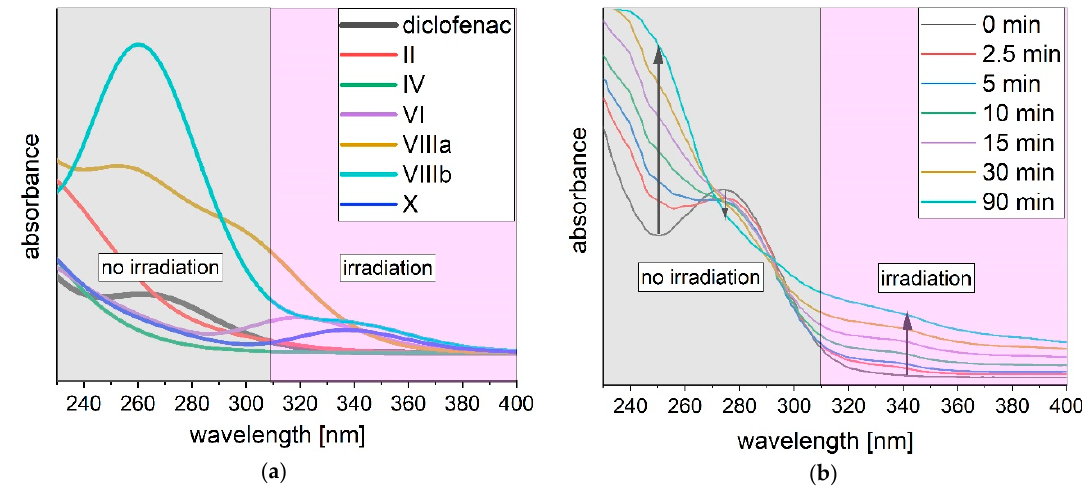
Figure 3. ( a ) Simulated absorption spectrum of diclofenac and selected transformation products (II–X). ( b ) Measured absorption spectrum of diclofenac at different irradiation times. The UVA lamp light emission ranges from 309–400 nm.